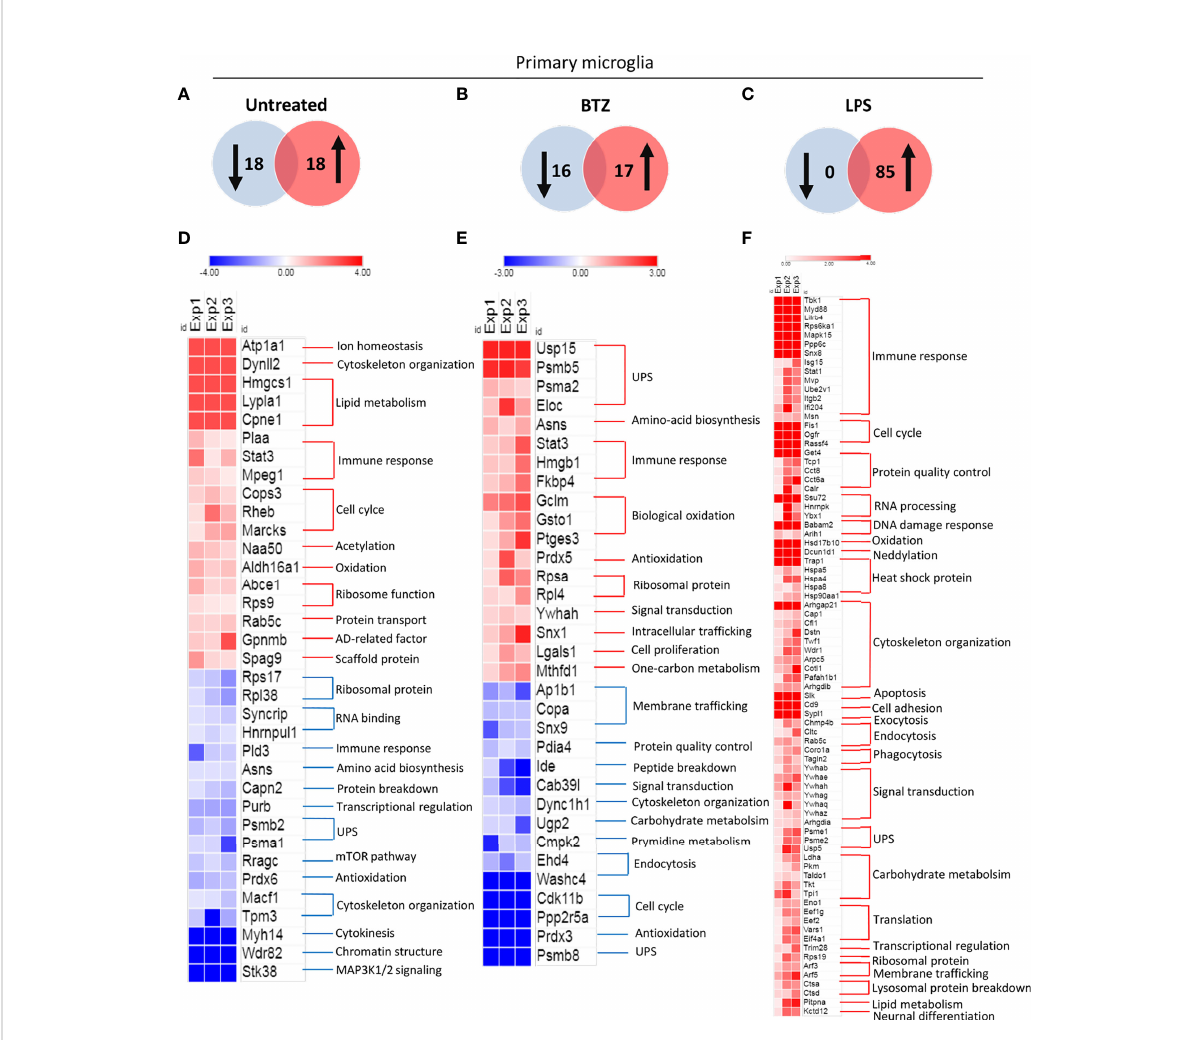
FIGURE 3 Immunoproteasome dysfunction alters the pro fi le of ubiquitylated proteins in primary microglia identi fi ed by proteomics. Identi fi ed ubiquitylated proteins were compared in WT and b 5i/LMP7 KO microglia by the fold changes of protein abundances. (A – C) Venn diagrams showing identi fi ed ubiquitylated protein numbers decreased (left, blue) and increased (right, red) in untreated (A) , 8h 50nM BTZ treated (B) , and 8h 1µg/mL LPS stimulated (C) b 5i/LMP7 KO primary microglia in comparison to WT untreated, 8h 50nM BTZ treated, and 8h 1µg/mL LPS stimulated primary microglia, respectively. (D – F) Heatmaps showing proteins increased (red) and decreased (blue) in untreated (D) , 8h 50nM BTZ treated (E) , and 8h 1µg/mL LPS stimulated (F) b 5i/LMP7 KO primary microglia in comparison to WT untreated, 8h 50nM BTZ treated, and 8h 1µg/mL LPS stimulated primary microglia, respectively. Heatmap data are given by log2 values of fold changes in protein abundances ((n=3) fold change cut off